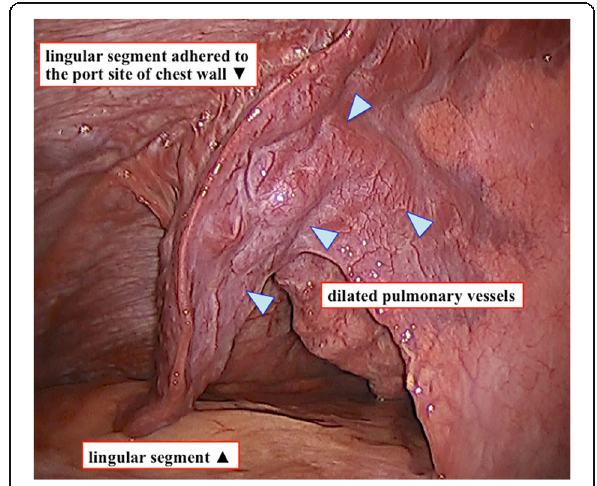
Fig. 2 Intraoperative findings at second surgery for left pneumothorax. The lingular segment with dilated pulsating pulmonary vessels (arrow heads) adhered to the port site of chest wall, which was made at the first video-assisted thoracic surgery for pneumothorax